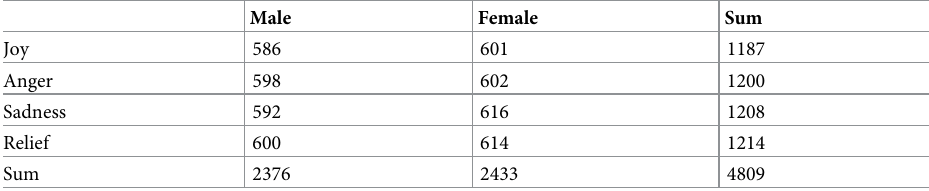
Table 5. Number of subjects for the experiment (long-term emotion). Male Female Sum 586 601 1187 598 602 1200 616 1208 600 614 1214 2433 4809